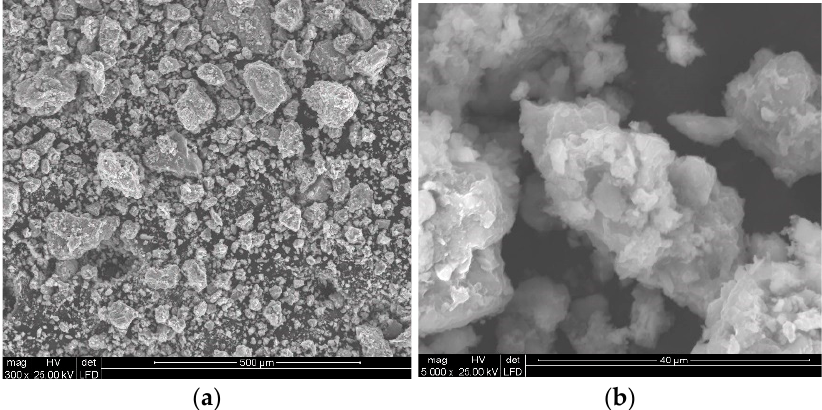
Figure 15. Example SEM images of the particles of concretions comminuted in a waterjet mill (for d w = 0.7 mm, d h = 2.4 mm, s = 10 mm, p = 150 MPa): ( a ) general view, ( b ) surface development.